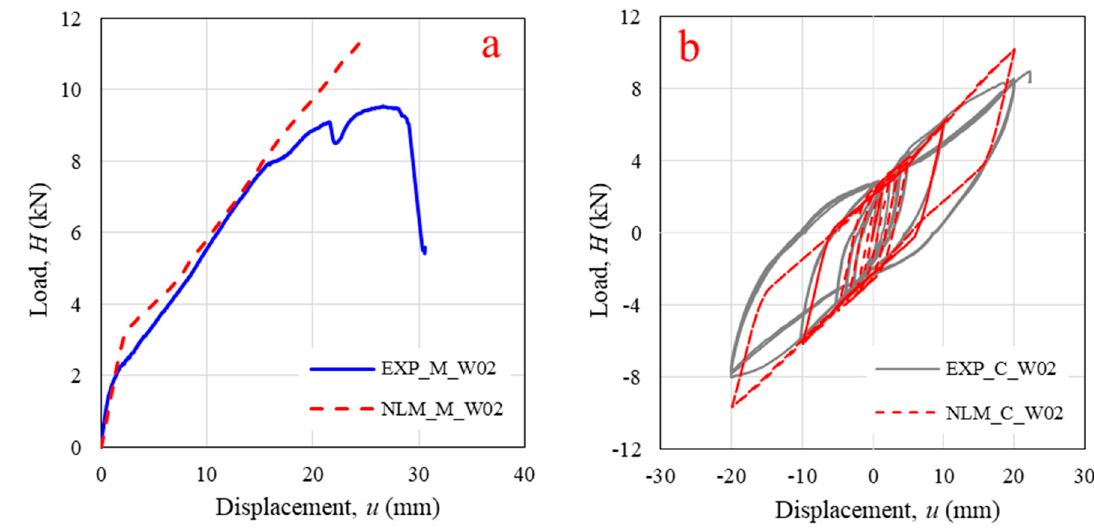
Figure 11. Comparison of experimental (EXP) and finite element model (FEM) results for specimen W02 under ( a ) monotonic loading; ( b ) cyclic